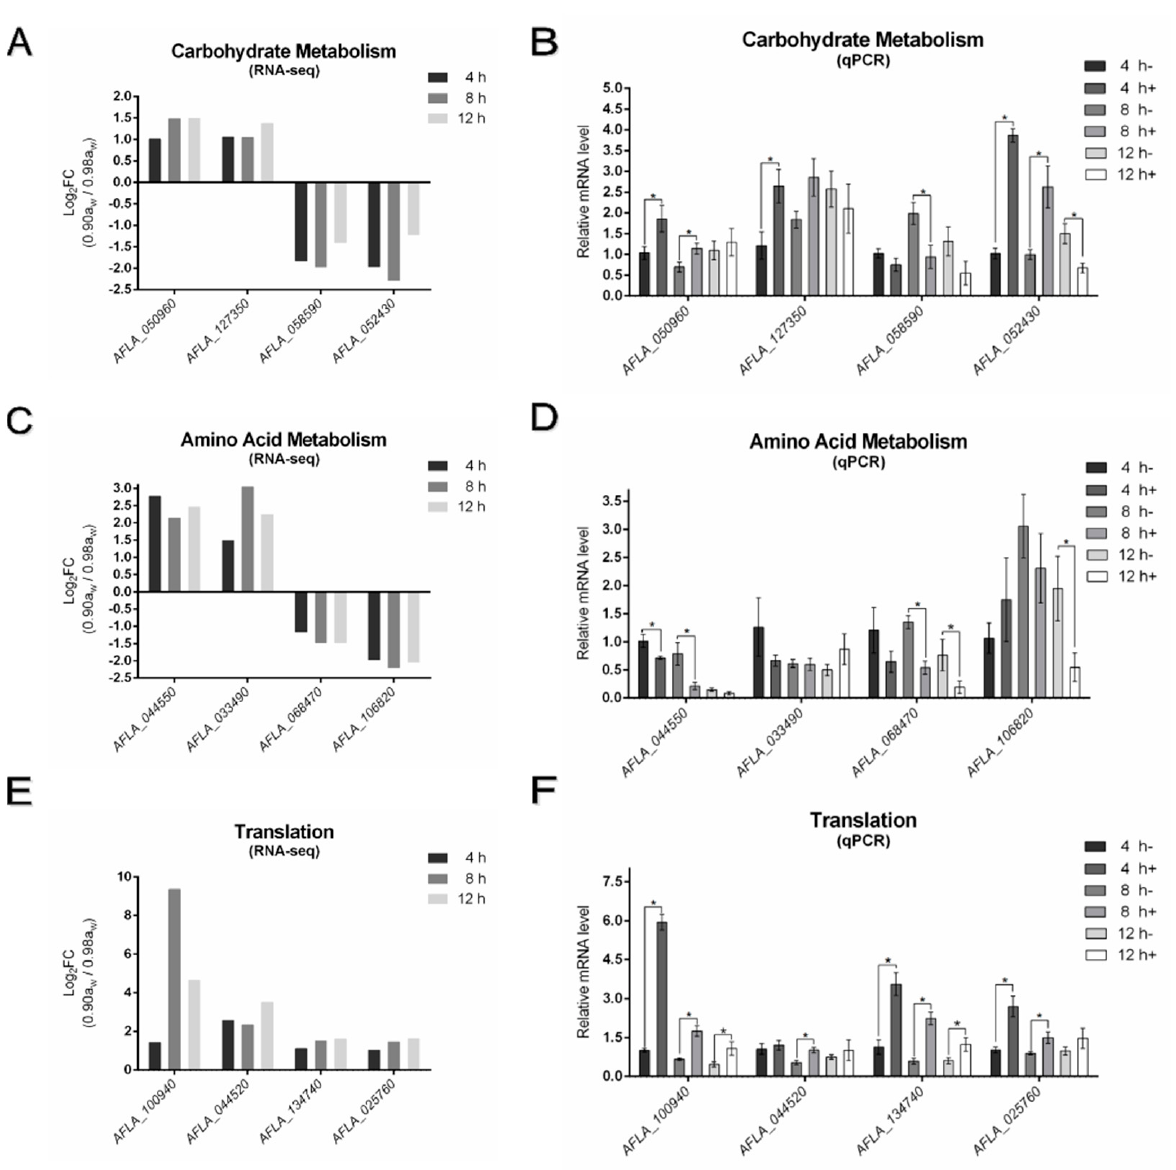
Figure 4. Fold change (FC) and real-time quantitative PCR of high regulated genes in three dominant pathways. − (0.98 a w ) and + (0.90 a w ) represented two different a w . Fold change of regulated genes in carbohydrate metabolism ( A ), amino acid metabolism ( C ) and translation ( E ). Real-time quantitative PCR of the four genes in carbohydrate metabolism ( B ), amino acid metabolism ( D ) and translation ( F ). The means and standard errors of duplicate samples have been plotted ( n = 6). Mean values with * were significantly different ( p <